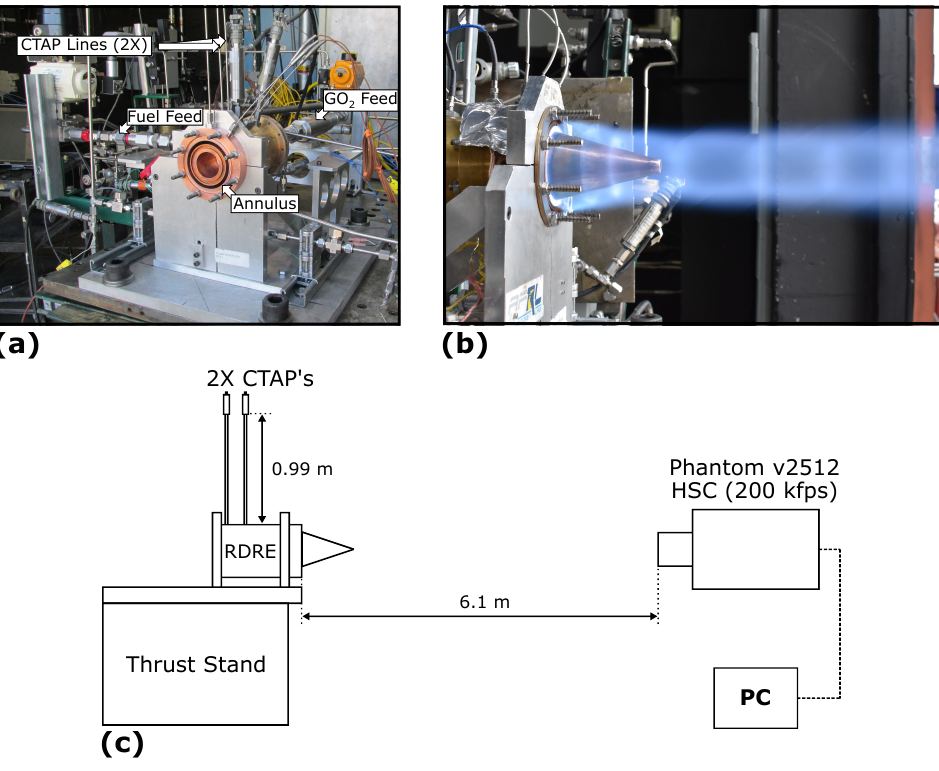
Figure 1. Depiction of the RDRE mounted on the thrust stand ( a ) before a test (labeled isometric view), ( b ) during a test firing (side view), and a ( c ) schematic view of the experimental apparatus with high-speed camera